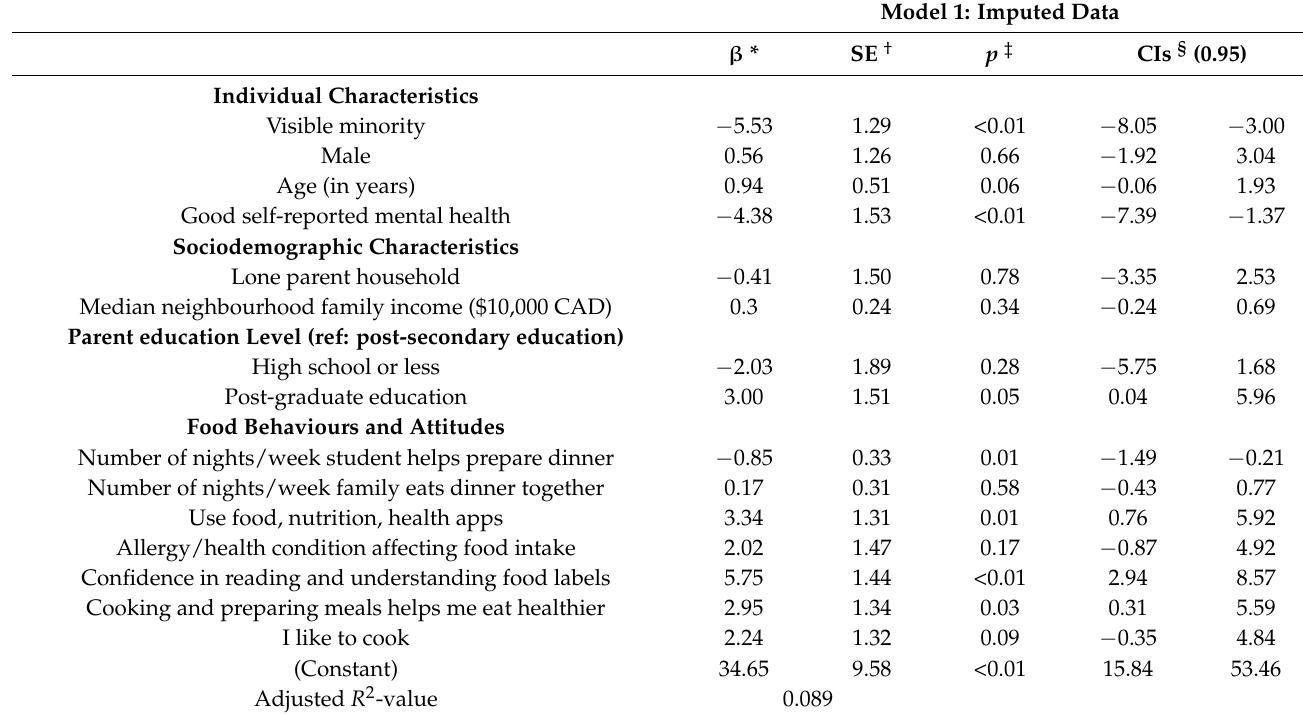
Table 4. Multiple Linear Regression for Food Knowledge Score (N =